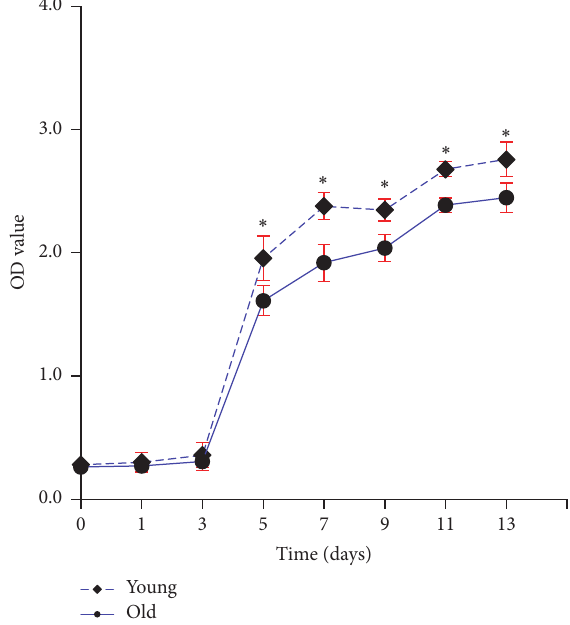
Figure 3: The growth curves of young and old NPMSCs detected by CCK-8 assay ( 𝑛 = 5 ). The OD values of young NPMSCs were significantly stronger than those of old NPMSCs during the logarithmicphase,indicatingabetterproliferationcapacityofyoung NPMSCs. The data are expressed as means ± SD. ∗ indicates 𝑃 < 0.05